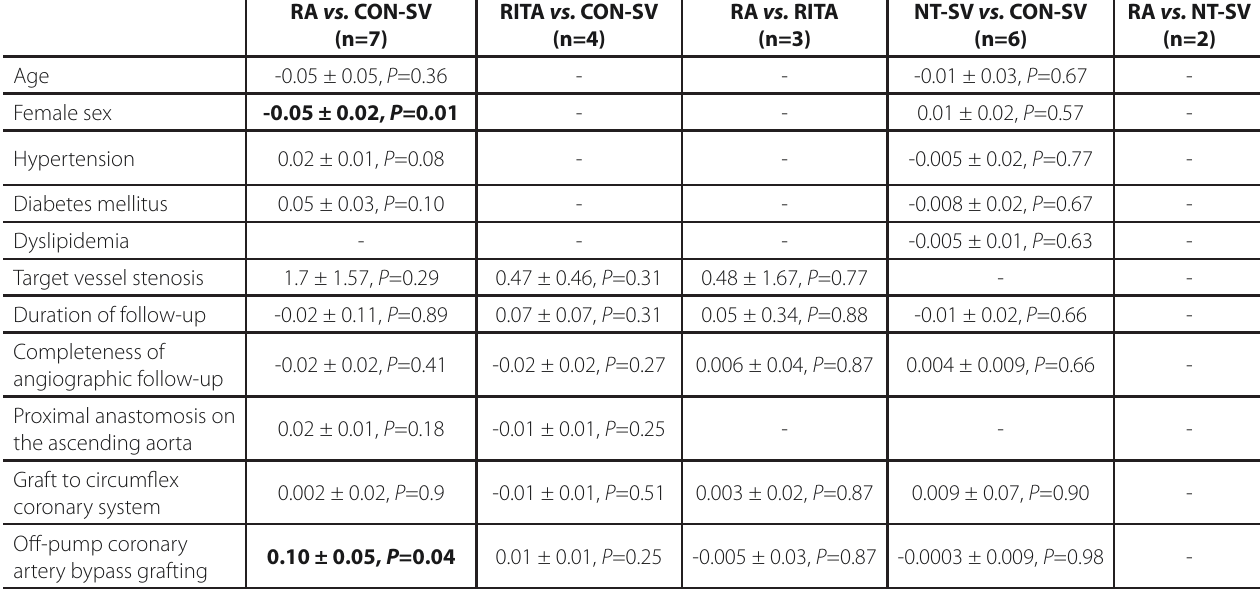
Table S9. Meta-regression for the primary outcome of graft